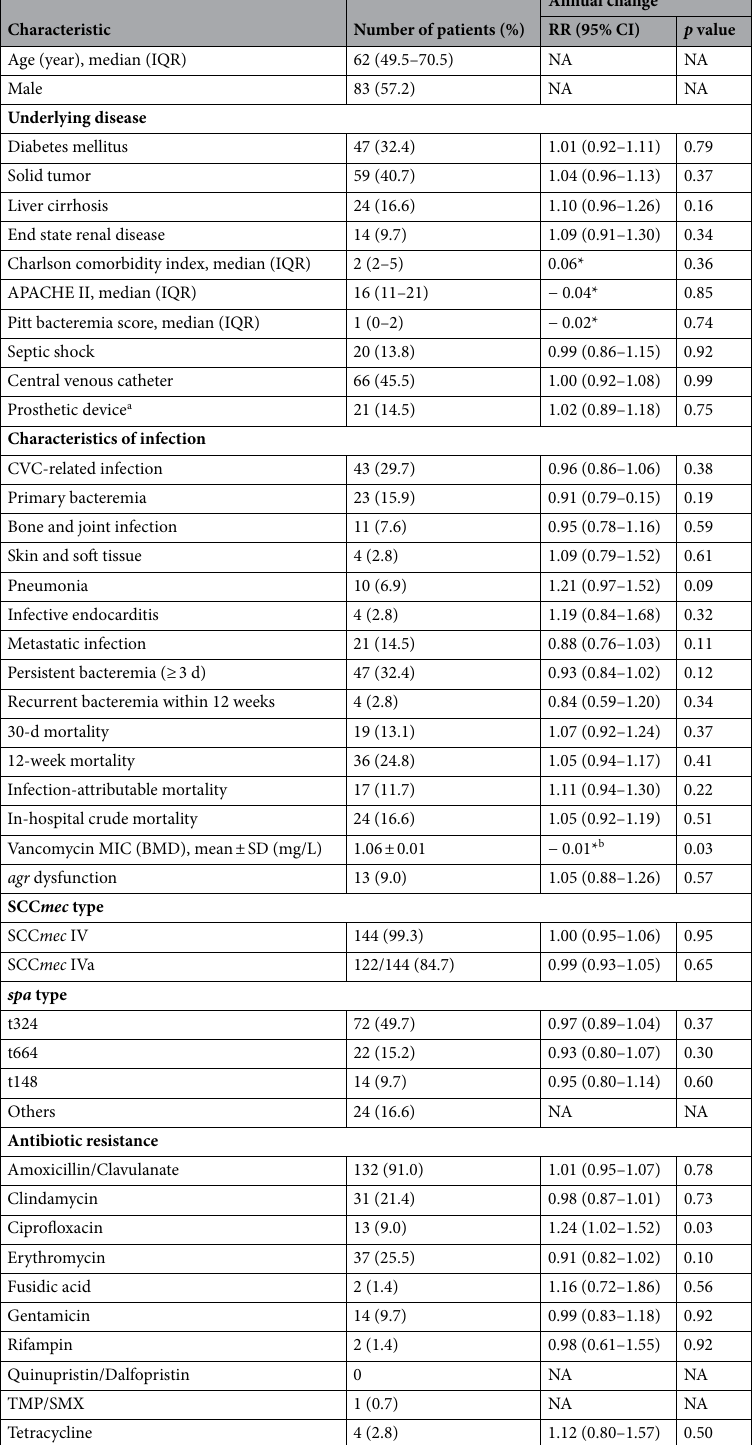
Table 4. Annual changes in clinical and microbiological characteristics of 145 patients with hospital-acquired infection. *A linear regression model was used for analysis. a Prosthetic device included orthopedic devices (six patients), cardiovascular implantable electronic devices (three patients), prosthetic valves (six patients), and vascular grafts (six patients) in patients with persistent bacteremia. b Result of linear regression: R 2 = 0.032, vancomycin MIC = 21.57 + (− 0.01) ×